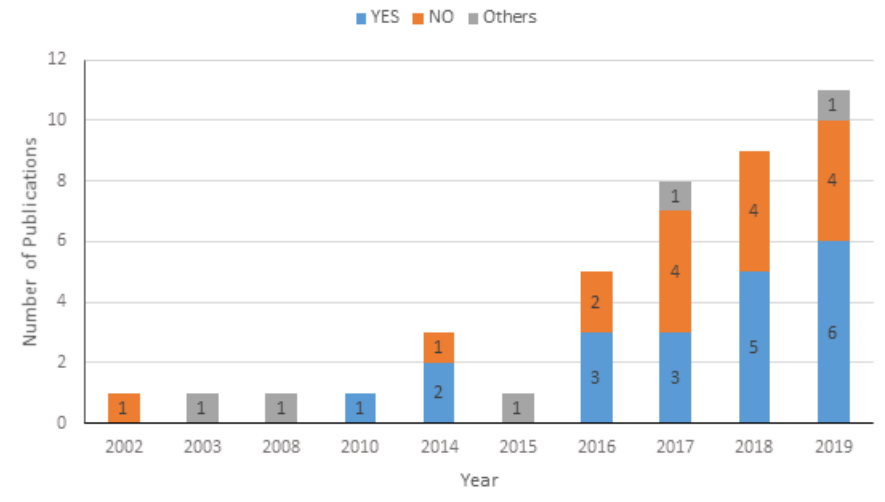
Figure 14. The evolution of data